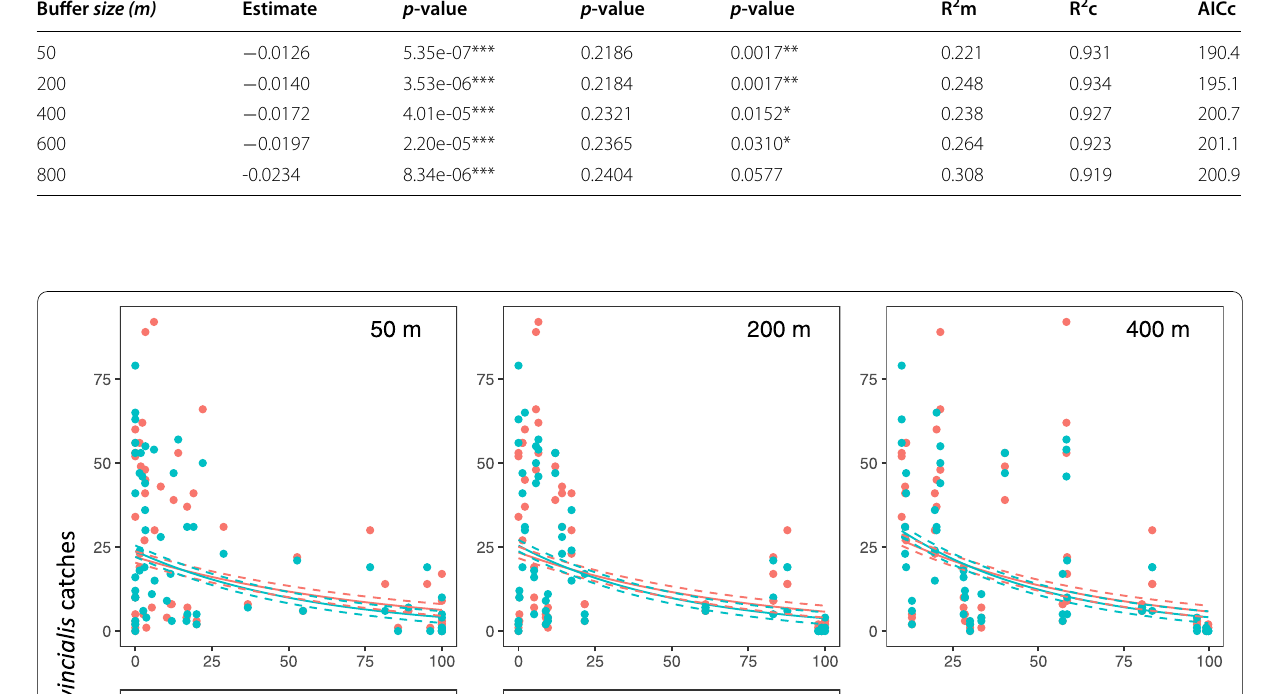
Table 1 Results of the linear mixed model for each buffer size around the traps . Explanatory variables were % P. pinea , sex, and their interaction. Significance of each explanatory variable is given ( P ‑value), and for the % P. pinea , the estimate is also provided. R 2 m corresponds to the variance explained by the fixed effects, R 2 c to the variance explained by fixed and random effects (trap within stand within sector). The AICc value of each model is also provided % P. pinea